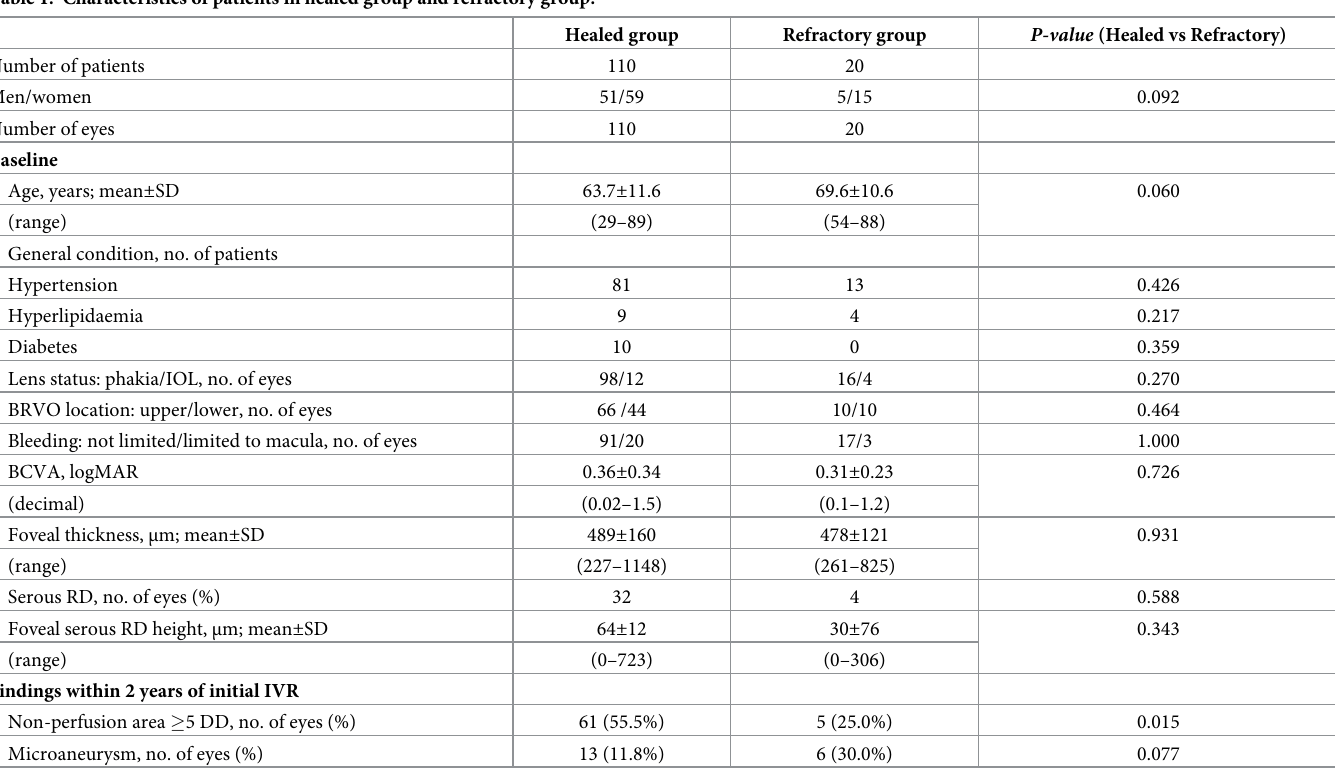
Table 1. Characteristics of patients in healed group and refractory